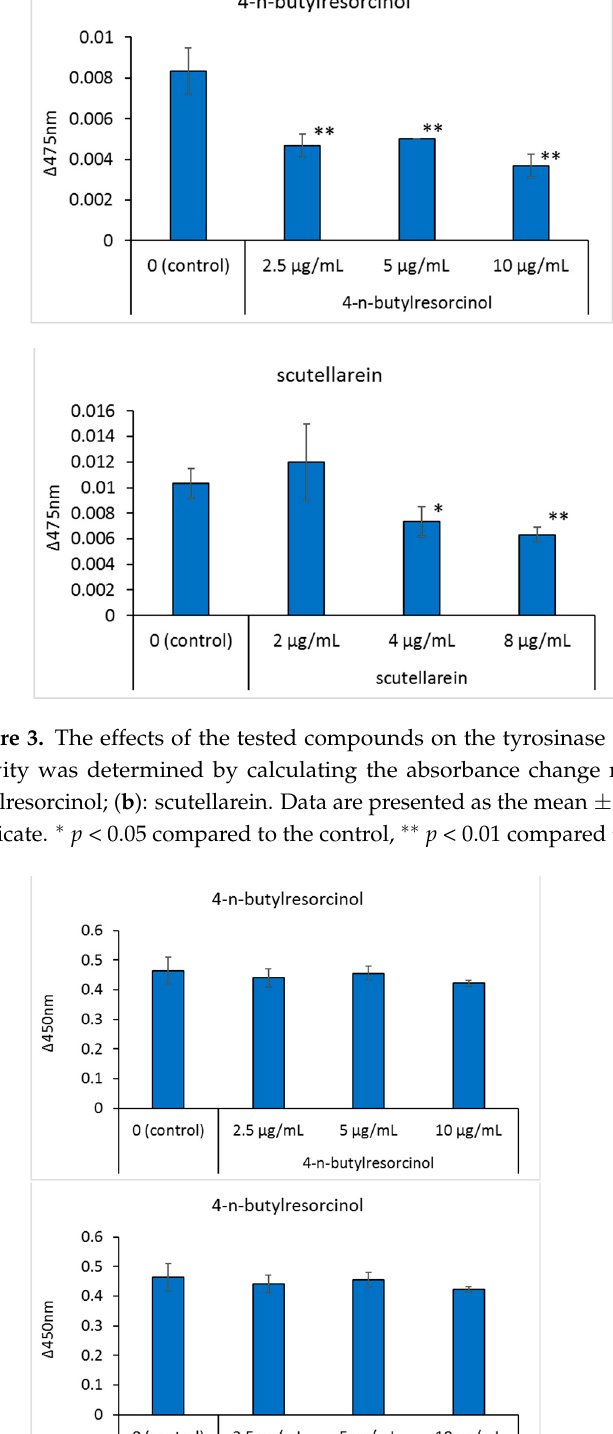
(c) Figure 2. Effects of the tested compounds on the melanin content of B16 cells. The upper part of the figure shows the appearance of the cell suspension after the addition of the NaOH solution. The lower part of the figure represents the absorbance of the cell pellet dissolved in NaOH; ab- sorbance was measured at 475 nm. Data are expressed as a percentage of the control. ( a ): 4-n-bu- tylresorcinol; ( b ): scutellarein; ( c ): baicalein. 3.2. Effects of Scutellarein on the Tyrosinase Activity in the Well Tyrosinase is an important enzyme for melanin production, and its regulation is one of the factors affecting skin pigmentation [25]. Tyrosinase activity in the well was deter-